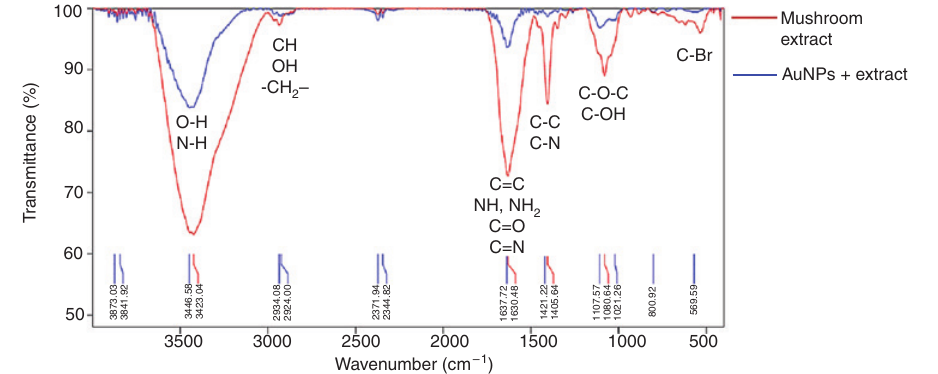
Figure 1: FT-IR spectrum of mushroom extract and mushroom extract containing AuNPs.